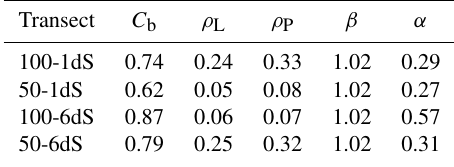
Table 2. Concordance parameters for the four transects for the TDR_FLT and EMI_ORG data. The table reports the concordance, ρ L , and the Pearson, ρ P , correlation, as well as parameters α and β of the MRA line. The bias factor, C b , is also